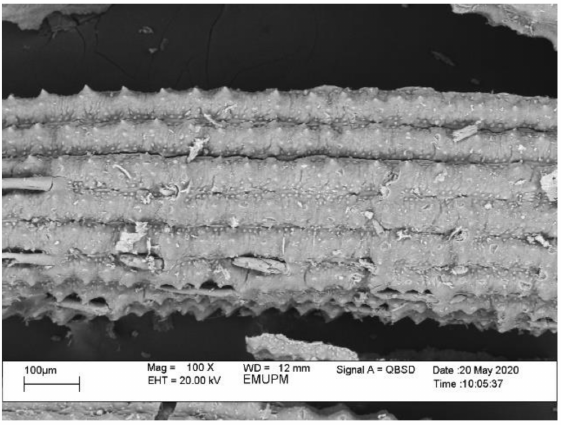
Figure 2. SEM image of the RHA structure before grinding. RHA has porous, cellular surfaces due to its sponge-like particles. Figure 3 shows the RHA structure after grinding. In a natural solid-state, the particles have a higher concentra- tion of silica with amorphous shapes similar to cristobalite and trace crystalline quartz [42].